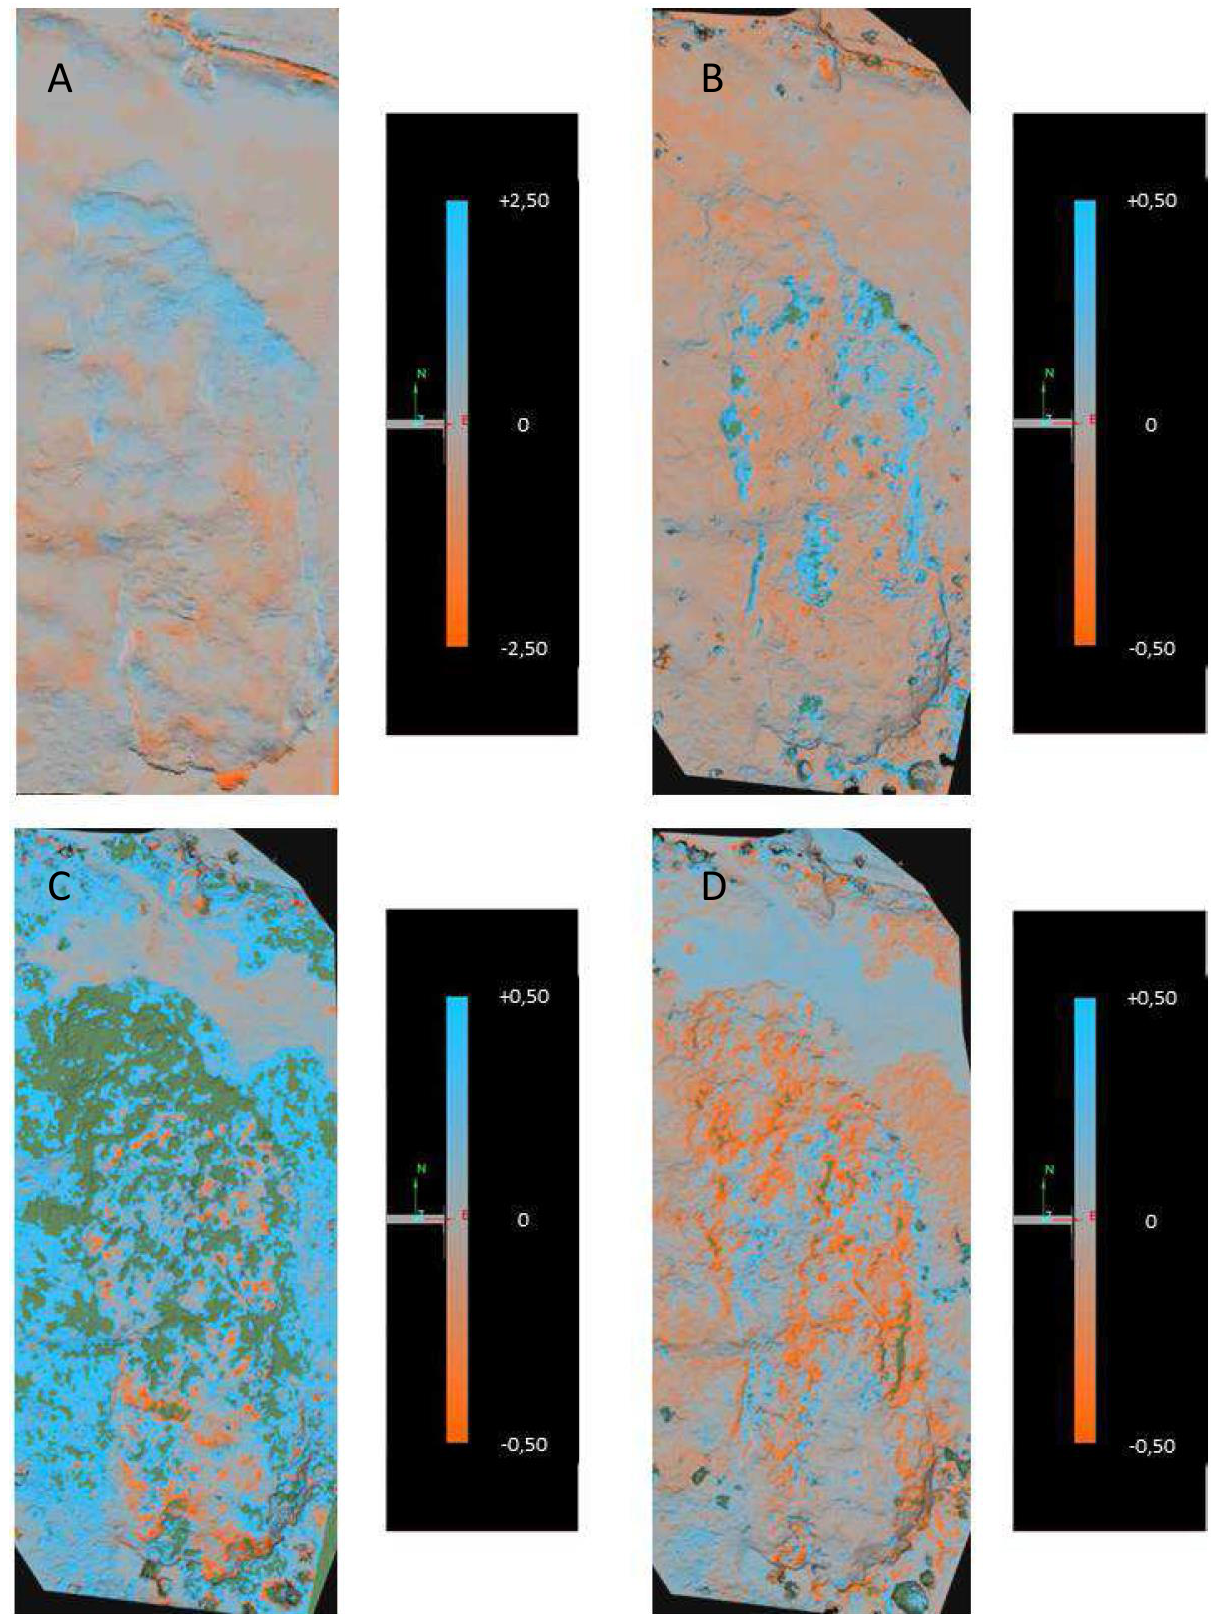
Figure 6. Landslide evolution. In orange: Areas where the DSM descends (depletion); in blue: Areas where the DSM ascends (accumulation or vegetation growth); green: Areas with changes out of range (intense growth of vegetation). A: May 2010-November 2012; B: November 2012- March 2013; C: November 2013- November 2013; D: November 2013-March